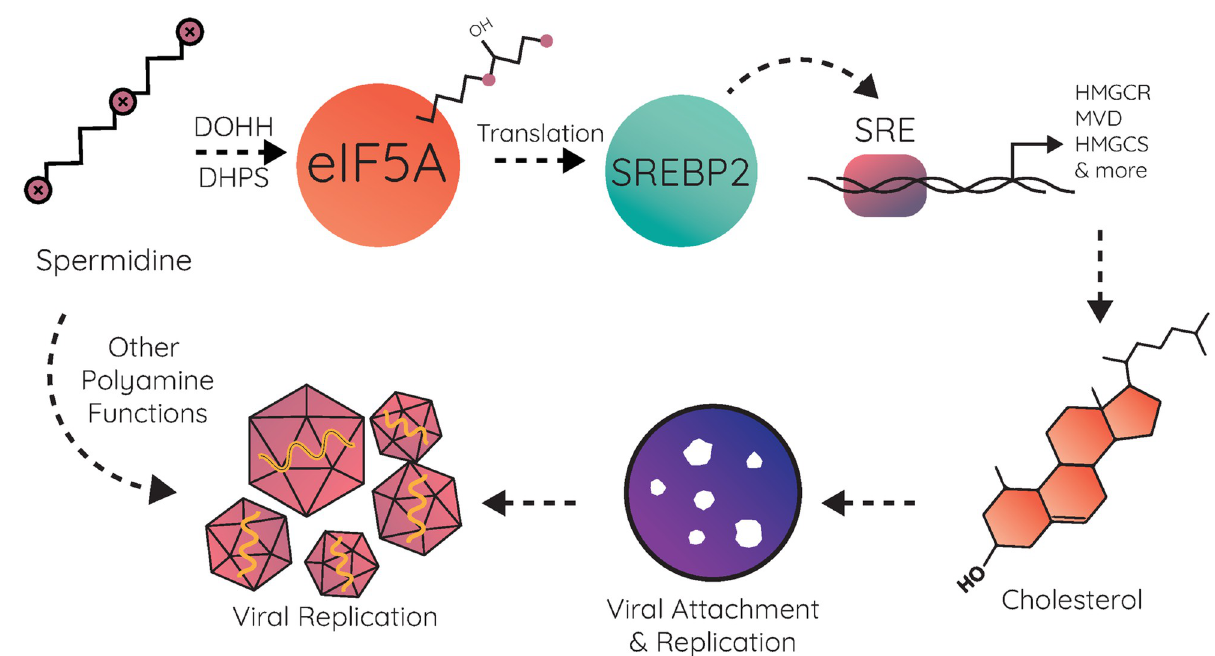
Fig 8. Working model. Polyamines facilitate hypusination of eIF5A, which promotes SREBP2 synthesis. SREBP2 binds to SREs on the promoters of cholesterol synthesis genes, leading to their expression and cholesterol synthesis. Cellular cholesterol synthesis enhances CVB3 attachment and, subsequently viral